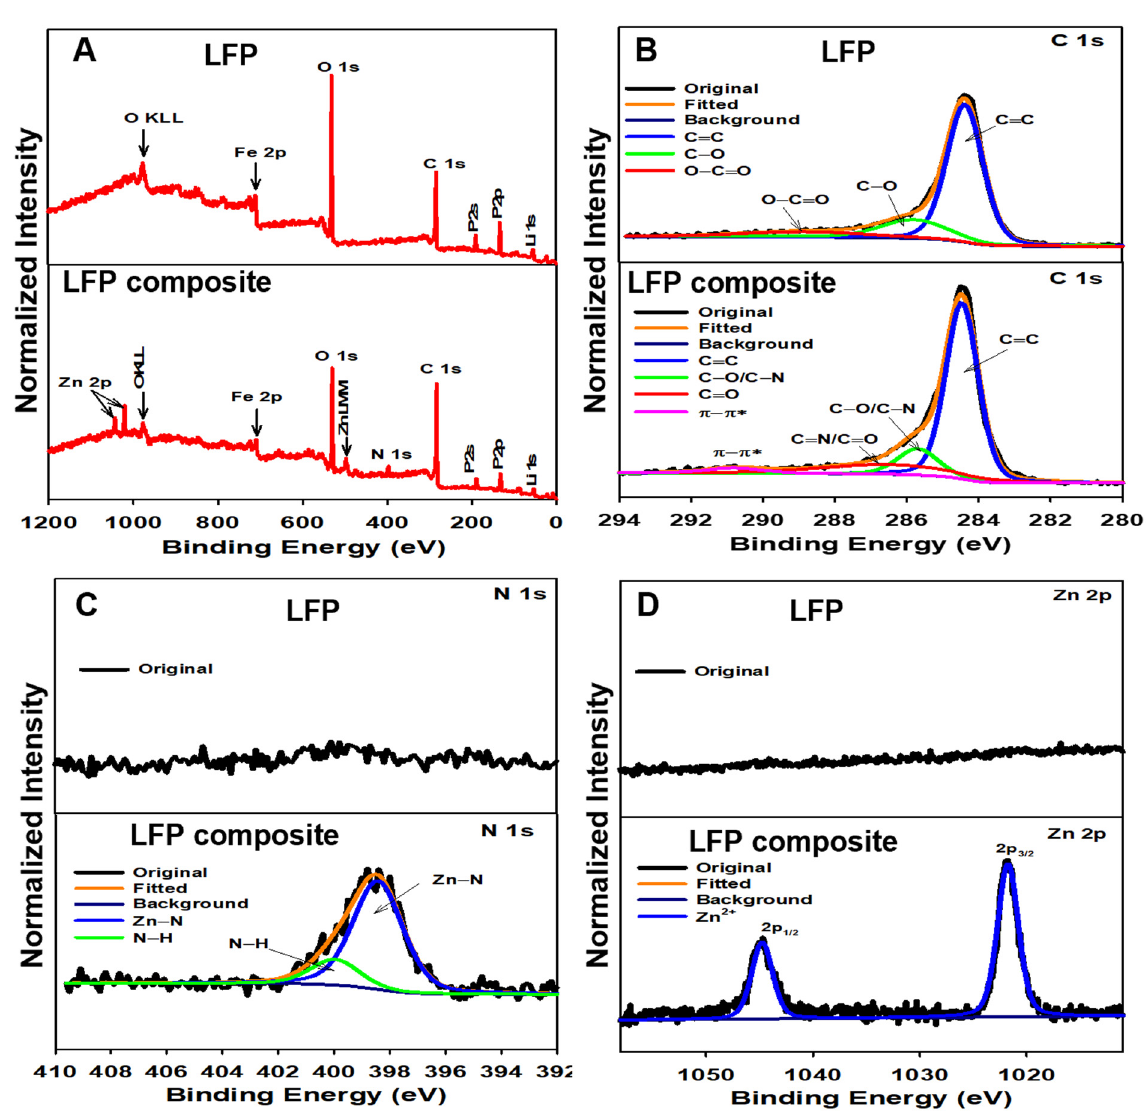
Figure 4. ( A ) Full survey spectra of the bare LFP and LFP composite (2% ZIF-8@LFP [A]/MWCNT). The deconvolution spectra of ( B ) C 1s, ( C ) N 1s, and ( D ) Zn 2p peaks of the bare LFP and LFP composite (2% ZIF-8@LFP [A]/MWCNT).